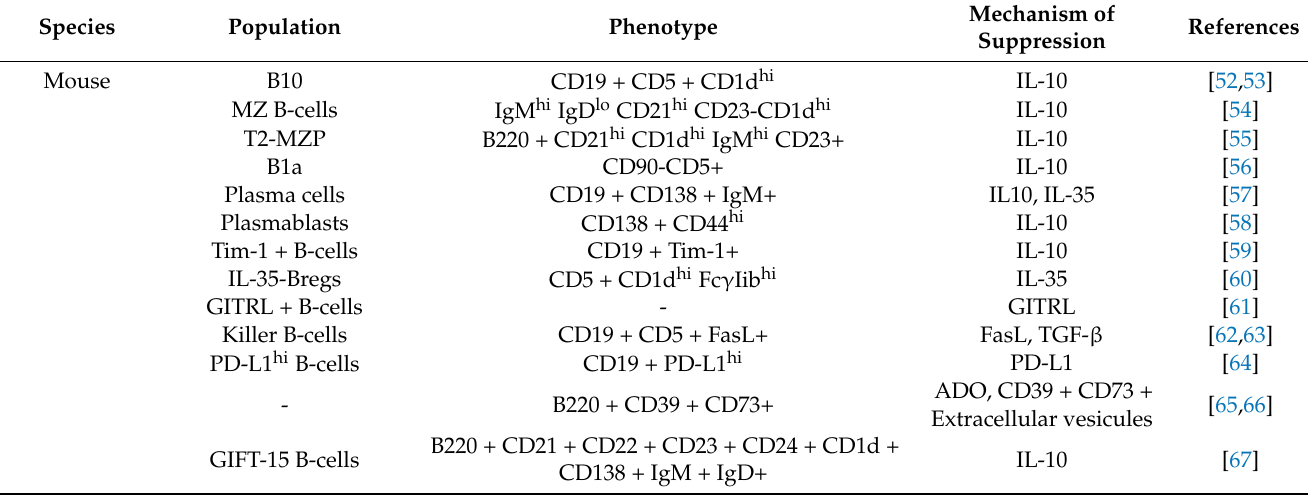
Table 1. Characteristics of several Breg populations in mice and